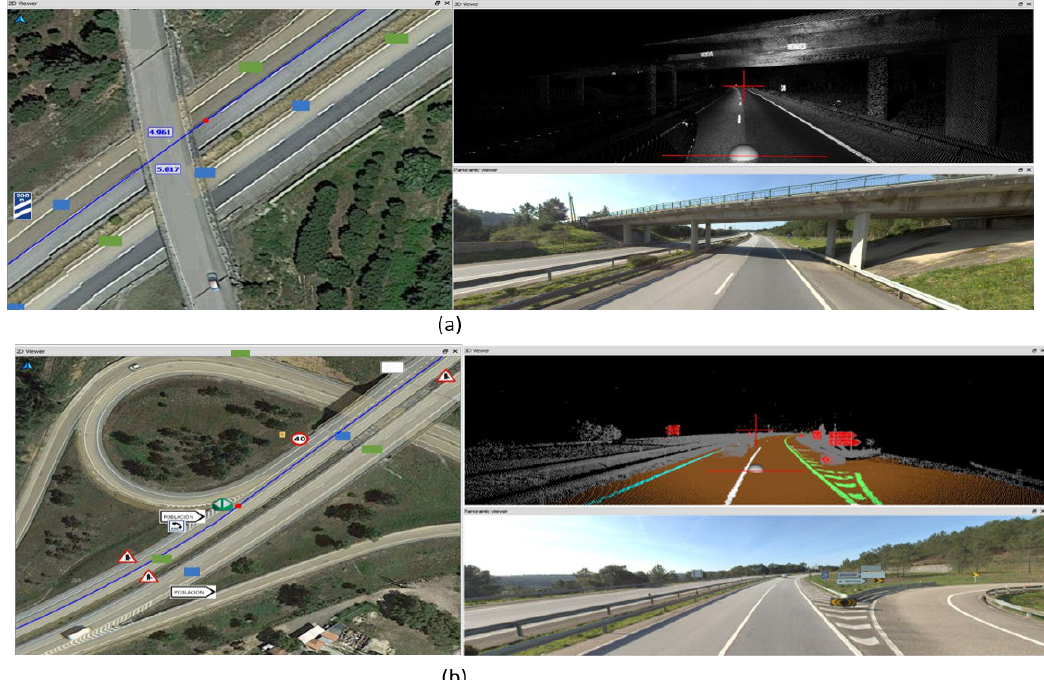
Figure 7. User interface. (a) Different views – 2D and 3D – of the infrastructure, with semantic layers (traffic signs and overpass clearance). (b) 3D view with the results of the semantic segmentation of the